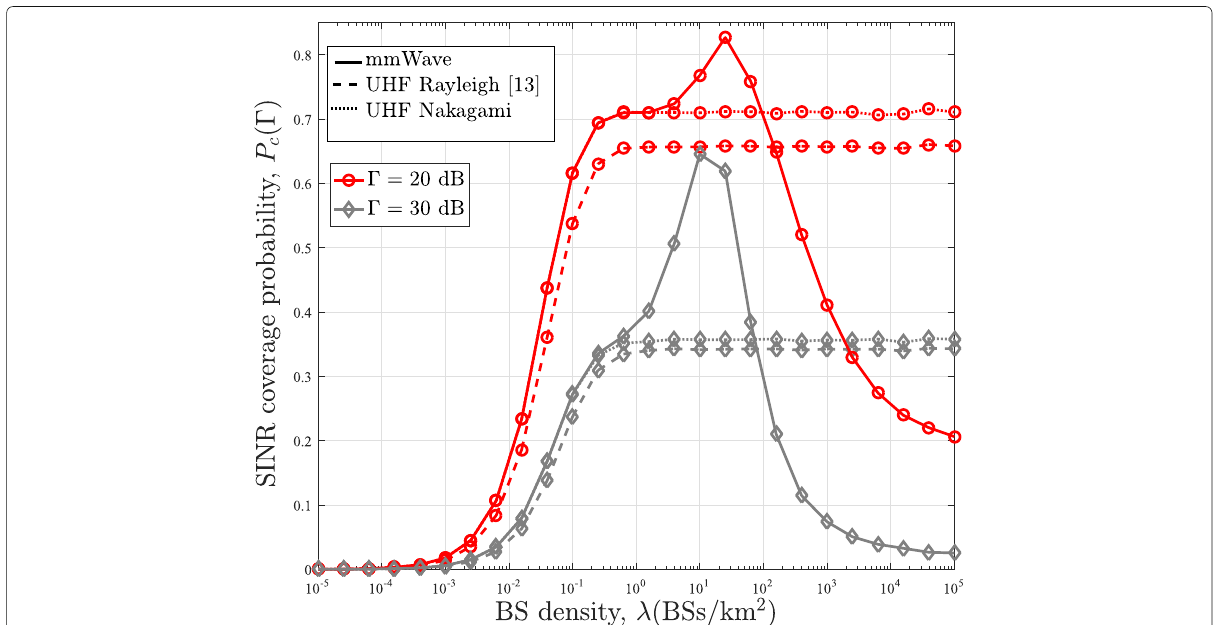
Fig. 8 Comparison of the SINR coverage probability of the mmWave and UHF networks in the uplink channel with the power control factor τ = 0